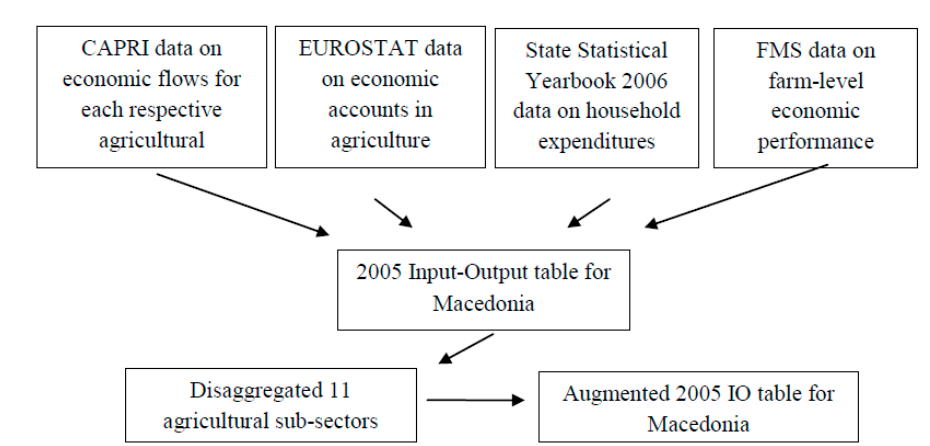
Figure 1. Steps involved in disaggregating the agriculture sector of the input–output table for Macedonia. Sub-sectoral outputs were calculated based on the EUROSTAT agricultural economic accounts.